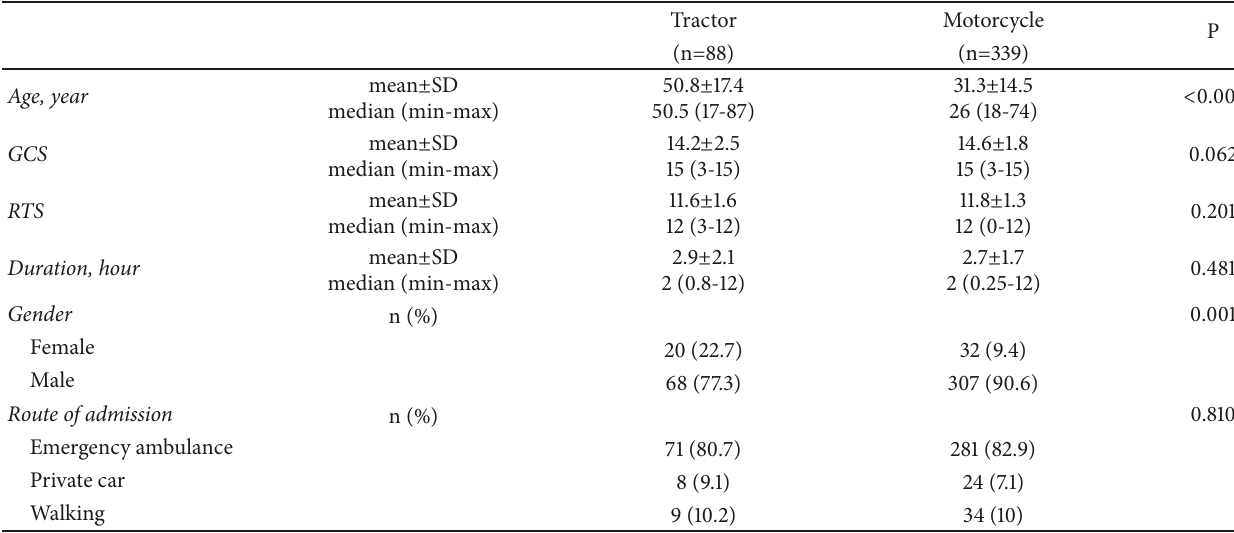
Table 1: General characteristics of the patients.